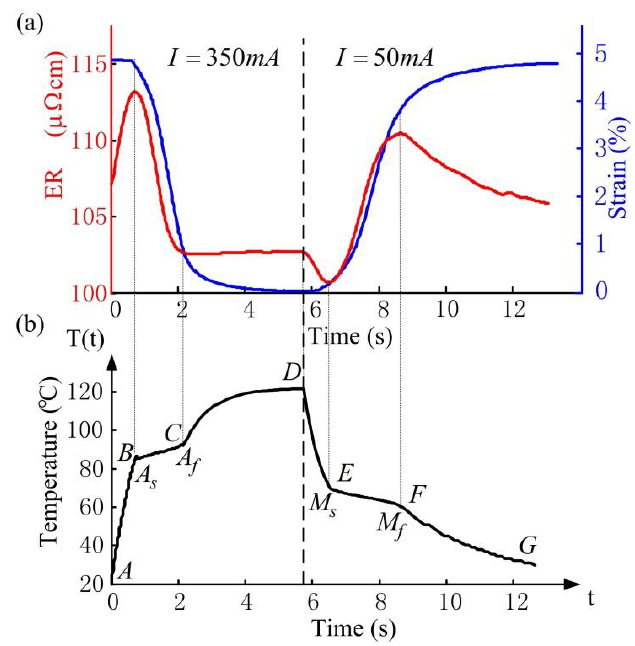
Figure 5. Experimental ER and strain response ( a ) and numerical temperature response ( b ) of SMA wire during heating (I = 350 mA) and cooling (I = 50